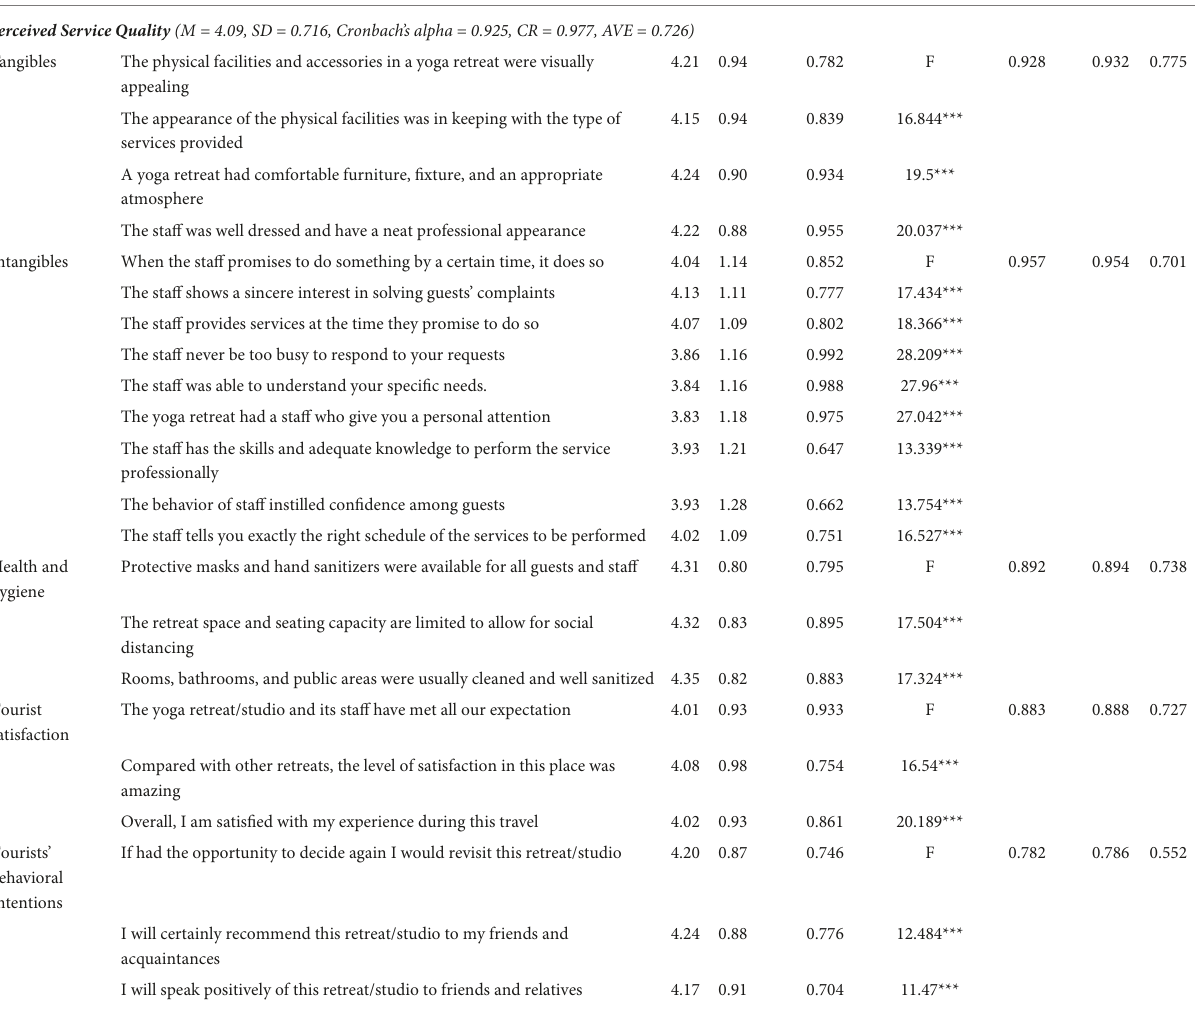
TABLE 5 Descriptive statistics, reliability, and confirmatory factor analysis properties.